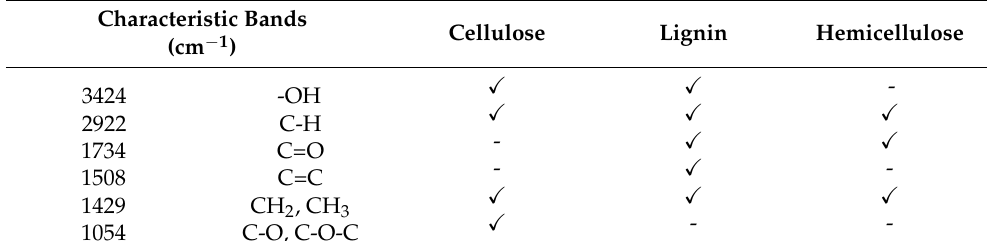
Figure 2. FTIR spectra of untreated, alkali-treated and cellulose fibers. Table 2. Characteristic bonds of different compounds of Ziziphus jujuba fiber.